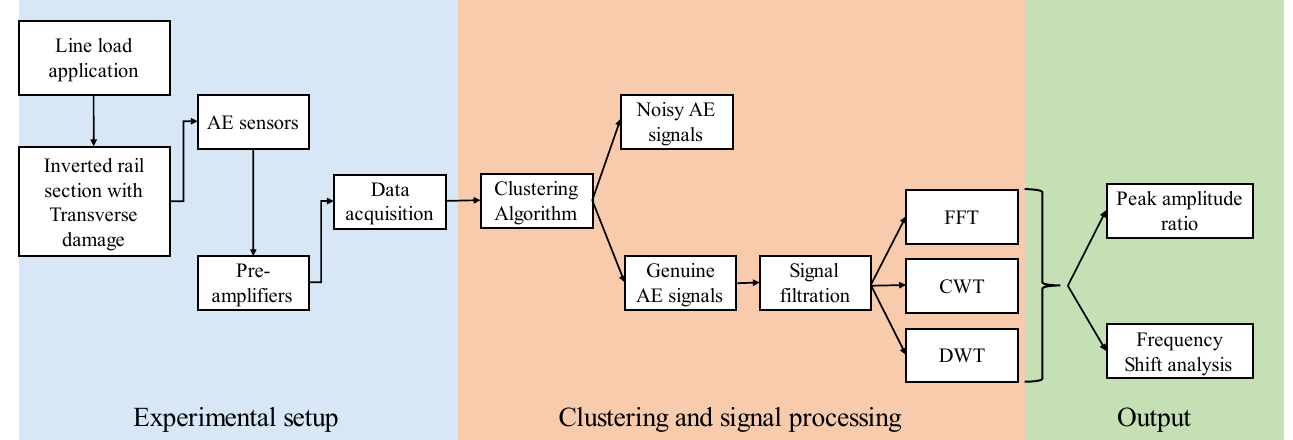
Figure 2. Technical flowchart of presented analysis on AE testing of rail.